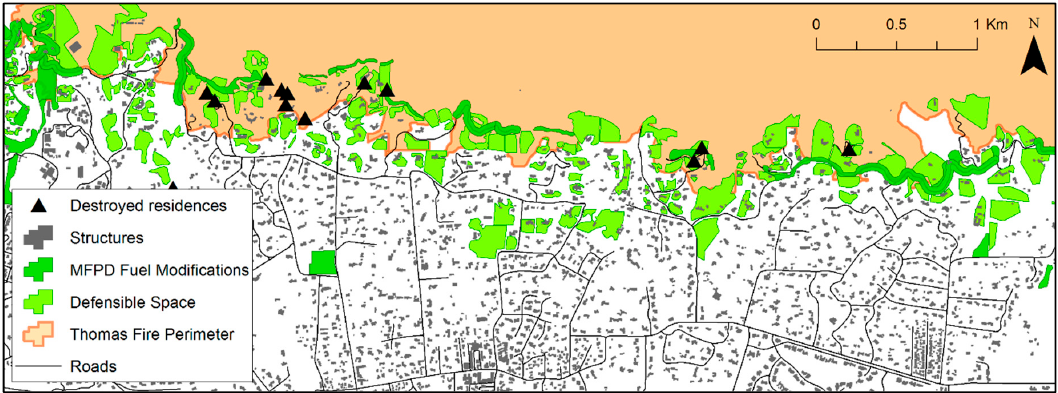
Figure 8. Montecito Fire Protection District fuel treatment network, homeowner defensible space, and locations of residences (both primary homes and guest houses) destroyed by the Thomas Fire in Montecito. (Adapted from [47]).